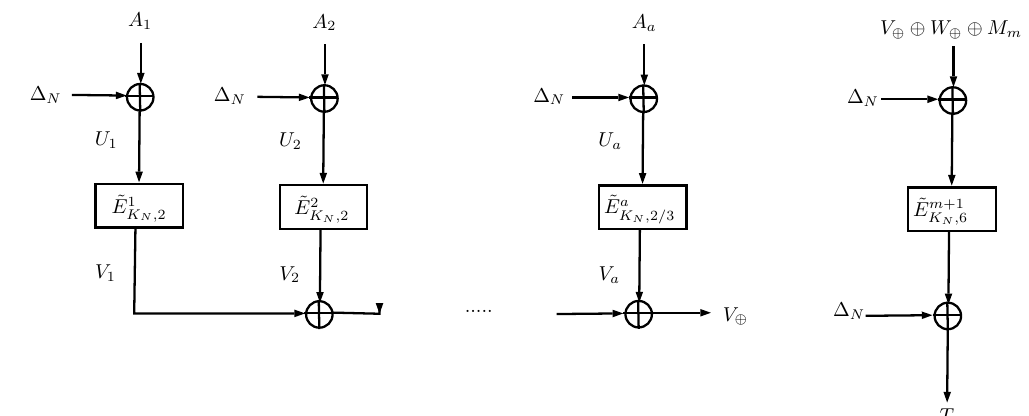
Figure 2. Block diagram for associated data processing and Tag generation for LOCUS and LOTUS.